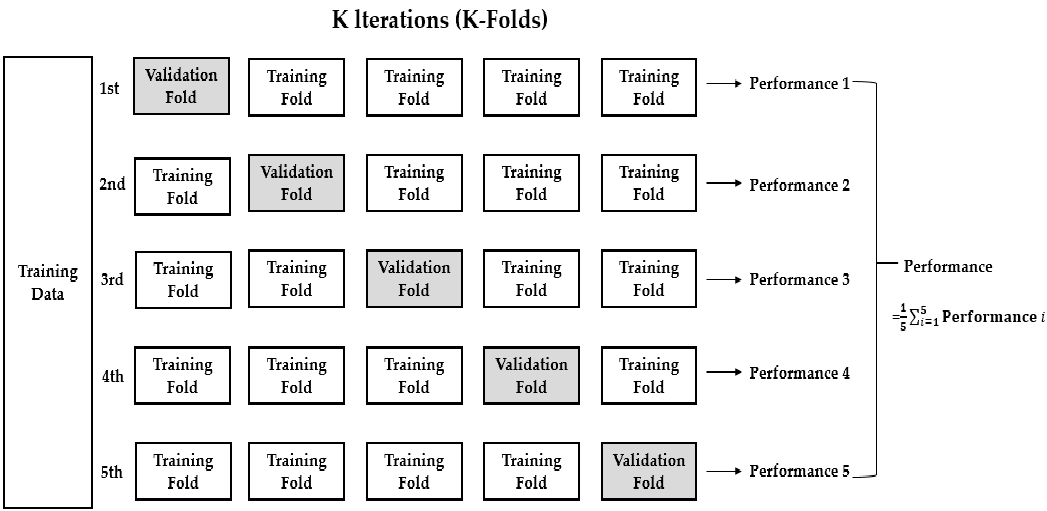
Figure 4. Five-fold cross-validation for data of dyslipidemia, hypertension, T2DM and over-weight/obesity.